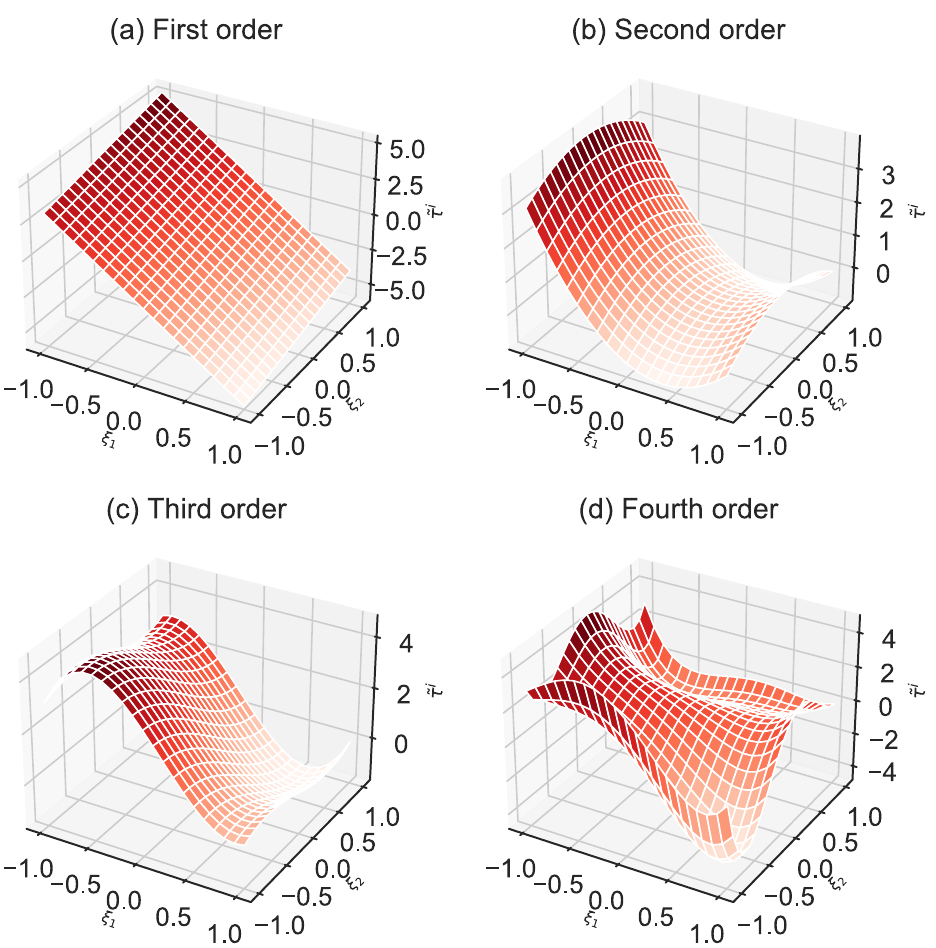
Figure 7. Approximate the local minimum value τ i of node i by aPC. These four subfigures show the results of aPC truncate to different orders from 1 to 4. If τ i > 0 , node i is resilient. Otherwise, the node loses resilience.